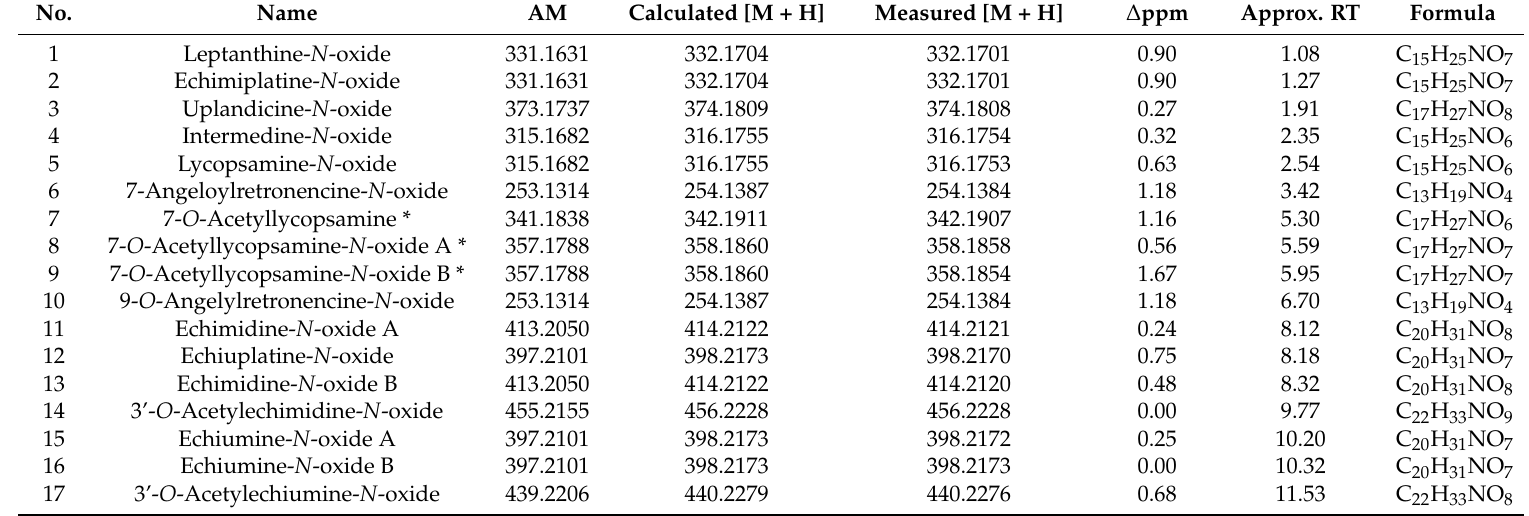
Table 1. Chromatographic and spectrometric properties of related pyrrolizidine alkaloids (PAs) and their N -oxides (PANOs) profiled by ultra high pressure liquid chromatography quadrupole time-of-flight (UHPLC-QTOF) mass speS. Compounds were annotated based on m/z of molecular ions and retention time (RT) in relation to results published previously [29]. “A” and “B”—Denote potential isomers; AM—Accurate mass; * Denotes compounds which could be intermedine